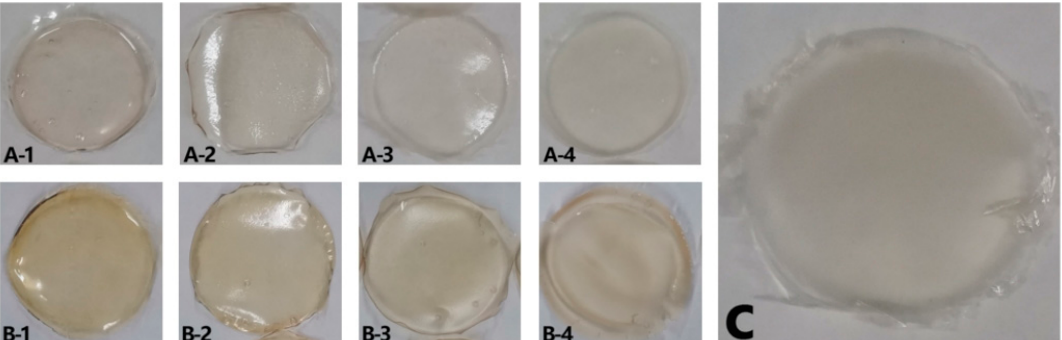
Figure 2. Visual appearance of the films. ( A-1 ) FA100, ( A-2 ) FA90FC10, ( A-3 ) FA70FC30, ( A-4 ) FA50FC50, ( B-1 ) FL100, ( B-2 ) FL90FC10, ( B-3 ) FL70FC30, ( B-4 ) FL50FC50, and ( C ) FC100. FA refers to acidified plasma protein, FL to lyophilized plasma protein, and FC to NFC. The number refers to the percentage of each component added to prepare the film.